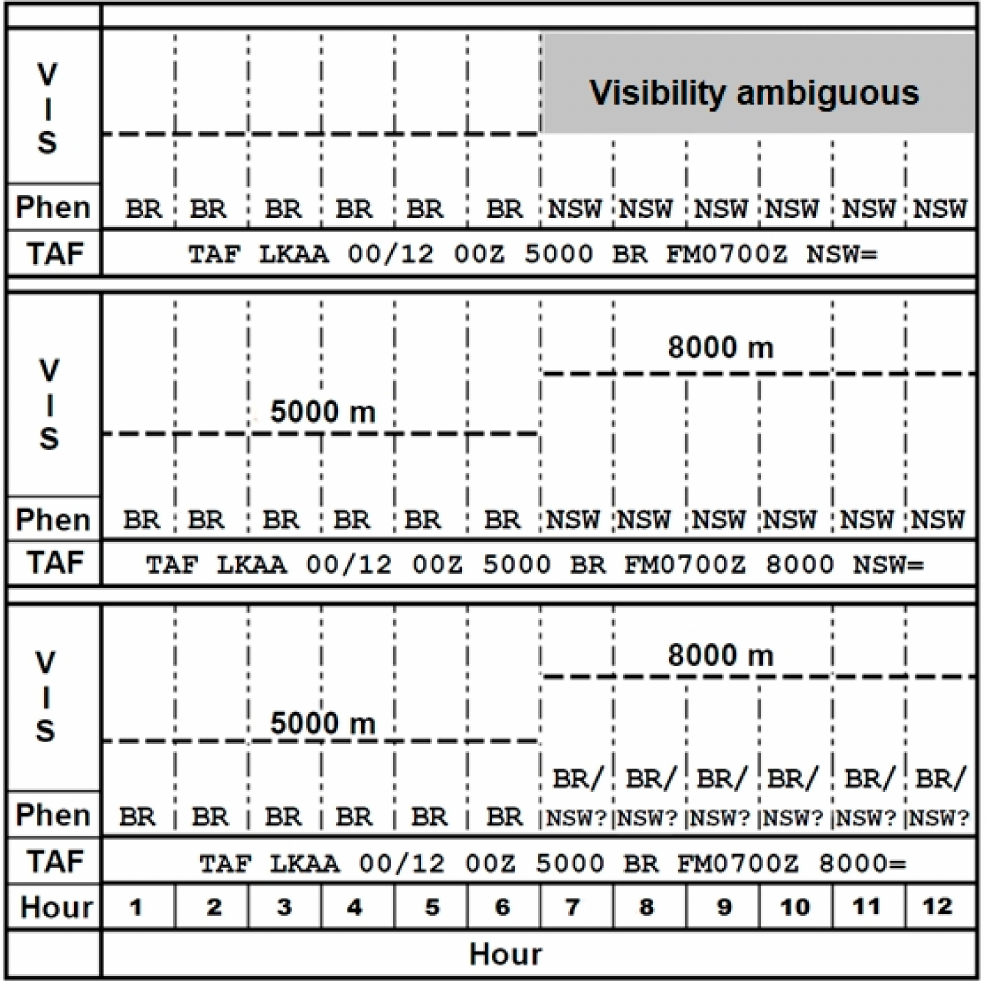
Figure 5. An example of problematic coding of